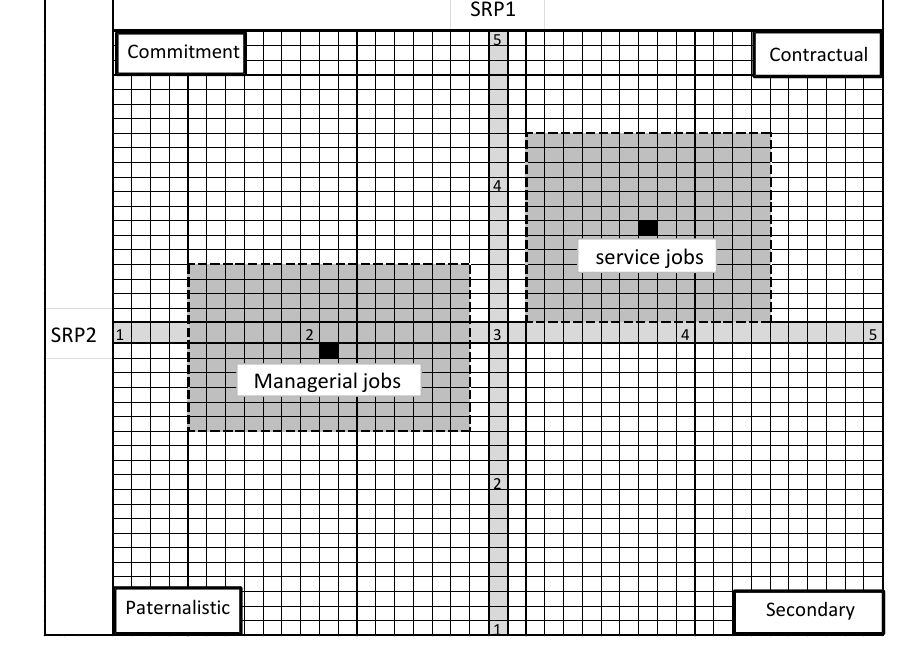
Figure 2. Determining the main SRP coordinates of managerial and service jobs